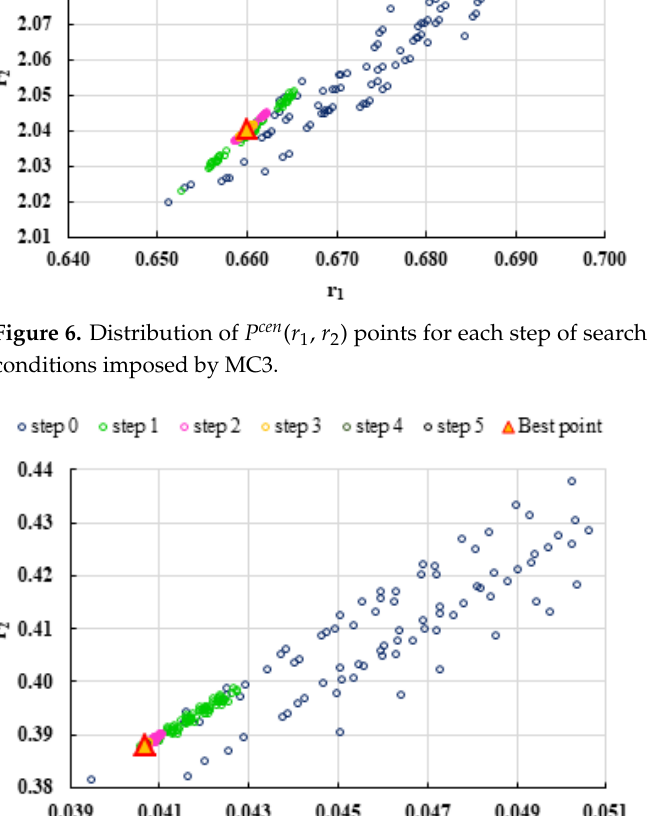
Figure 7. Distribution of P cen ( r 1 , r 2 ) points for each step of searching for the k-NN method for the conditions imposed by HC1.